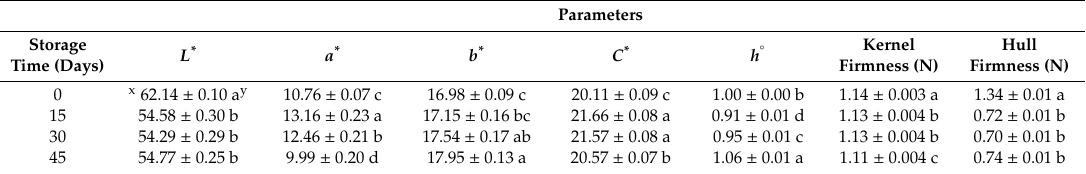
Table 2. Changes in external hull color parameters ( L * , a * , b * , chroma, and h ◦ ), kernel firmness, and hull firmness of fresh in-hull pistachios packaged under passive- and active-MAP conditions, and stored for 45 days at 4 ± 1 ◦ C and 90 ± 5%